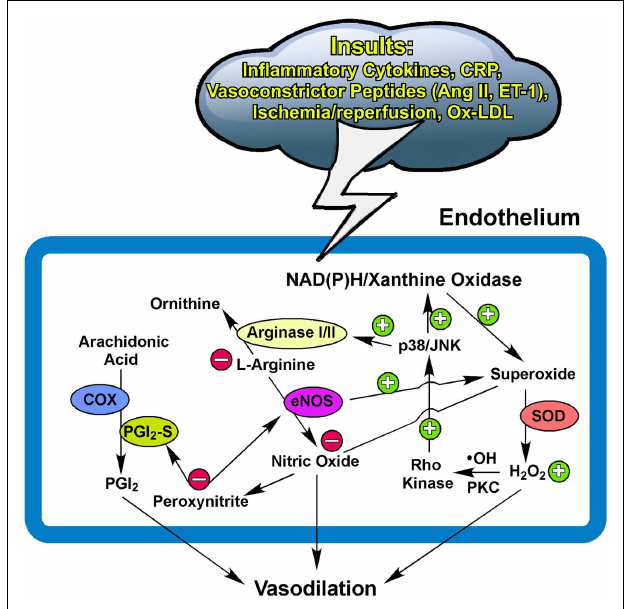
FIGURE 1 | Potential pathways for redox and arginase modulation of vasomotor function .The low level of superoxide and hydrogen peroxide (H 2 O 2 ) is essential for maintaining normal homeostasis of the endothelium to exert vasodilation in response to physiological stimulation.The excessive production of superoxide from the activated NAD(P)H oxidase and/or xanthine oxidase by insults from inflammatory cytokines, C-reactive protein (CRP), ischemia/reperfusion, oxidized low-density lipoprotein (Ox-LDL), or vasoconstrictor peptides such as angiotensin II (Ang II) and endothelin-1 (ET-1) (162–165) scavenges the released nitric oxide and subsequently forms peroxynitrite.The prolonged and elevated production of H 2 O 2 from superoxide dismutase (SOD) suppresses NO production by up-regulating vascular arginase via p38 mitogen-activated protein kinase or c-Jun-N-terminal kinase (JNK) signaling following the hydroxyl radical ( • OH)- or protein kinase C (PKC)-mediated activation of Rho kinase.The upregulated arginase limits substrate L -arginine availability to nitric oxide synthase (eNOS) for nitric oxide synthesis and also uncouples eNOS to promote superoxide production.The production of nitric oxide from eNOS and prostacyclin (PGI 2 ) from cyclooxygenase (COX) and PGI 2 synthase (PGI 2 -S) is inhibited by peroxynitrite due to uncoupling of eNOS and nitration of PGI 2 -S (see text for details). Peroxynitrite also activates